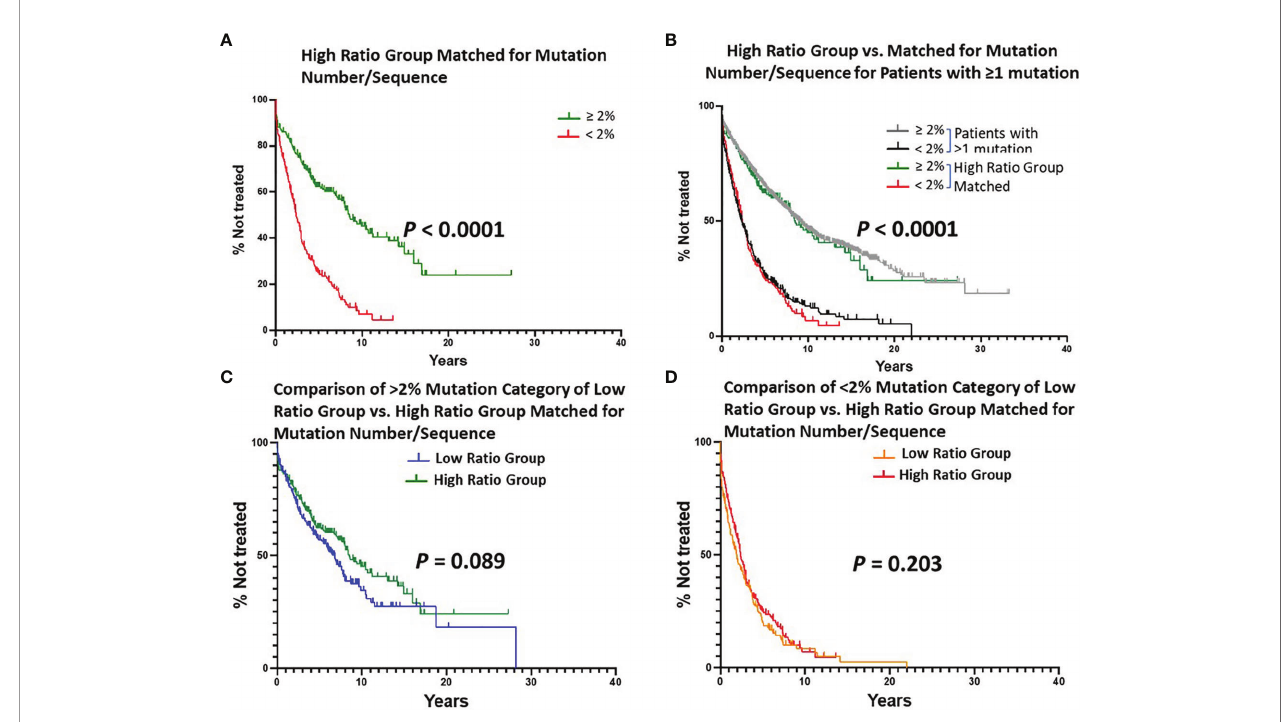
FIGURE 5 | Estimated TTFT of patients in the Low or High Ratio Groups matched for numbers of patients and mutations per sequence. A, B, C, (D) Layout of graphs as per Figure 2 . An exact matching approach with random sampling was used to achieve equal numbers of patients (n = 405) with the same number of IGHV mutations per patient (1-36) in the Low Ratio and High Ratio Groups. (A) Number of cases in the < 2% difference group: 187, 148 treated (median TTFT = 2.42 years); number of cases in the ≥ 2% difference group: 218, 101 treated (median TTFT = 8.50 years) (P < 0.0001). (B) TTFT based on the < 2% vs. ≥ 2% difference from the germline IGHV sequence using all patient sequences ( Figure 1B ) and those sequences in Matched High Ratio group. (C) Number of cases from Low Ratio group: 222, 119 treated (median TTFT = 6.78 years). Number of cases from Matched High Ratio group: 218, 101 treated (median TTFT = 8.50 years). (D) Number of cases from Low Ratio group: 183, 152 treated (median TTFT = 1.91 years). Number of cases from High Ratio group: 187, 148 treated (median TTFT = 2.42